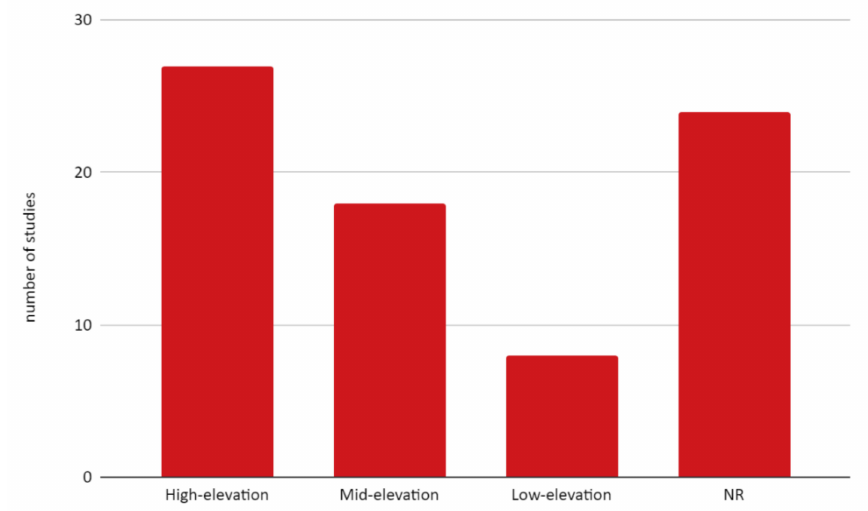
Figure 5. Elevation of study sites.